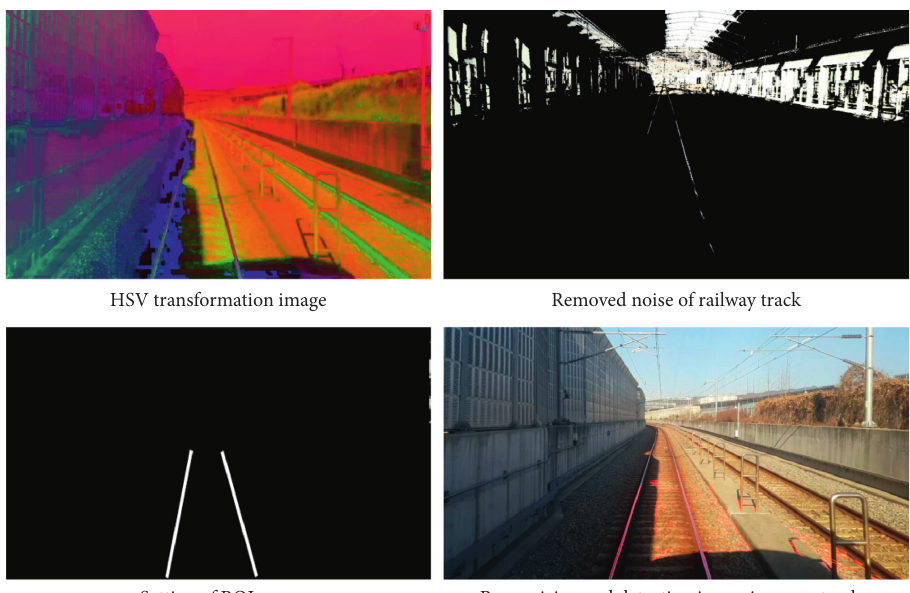
Figure 3: Process of algorithm to detect and recognize railway tracks.